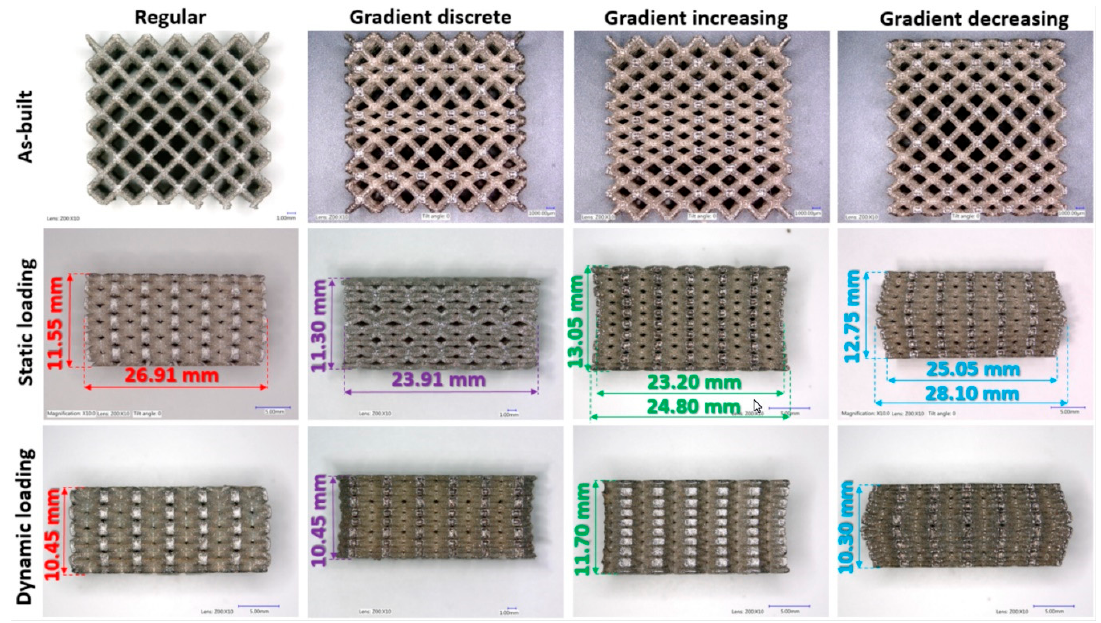
Metals 2019 , 9 , x FOR PEER REVIEW Figure 18. The deformation of lattice structures with different topologies after static and dynamic Figure 18. The deformation of lattice structures with di ff erent topologies after static and dynamic testing. testing.